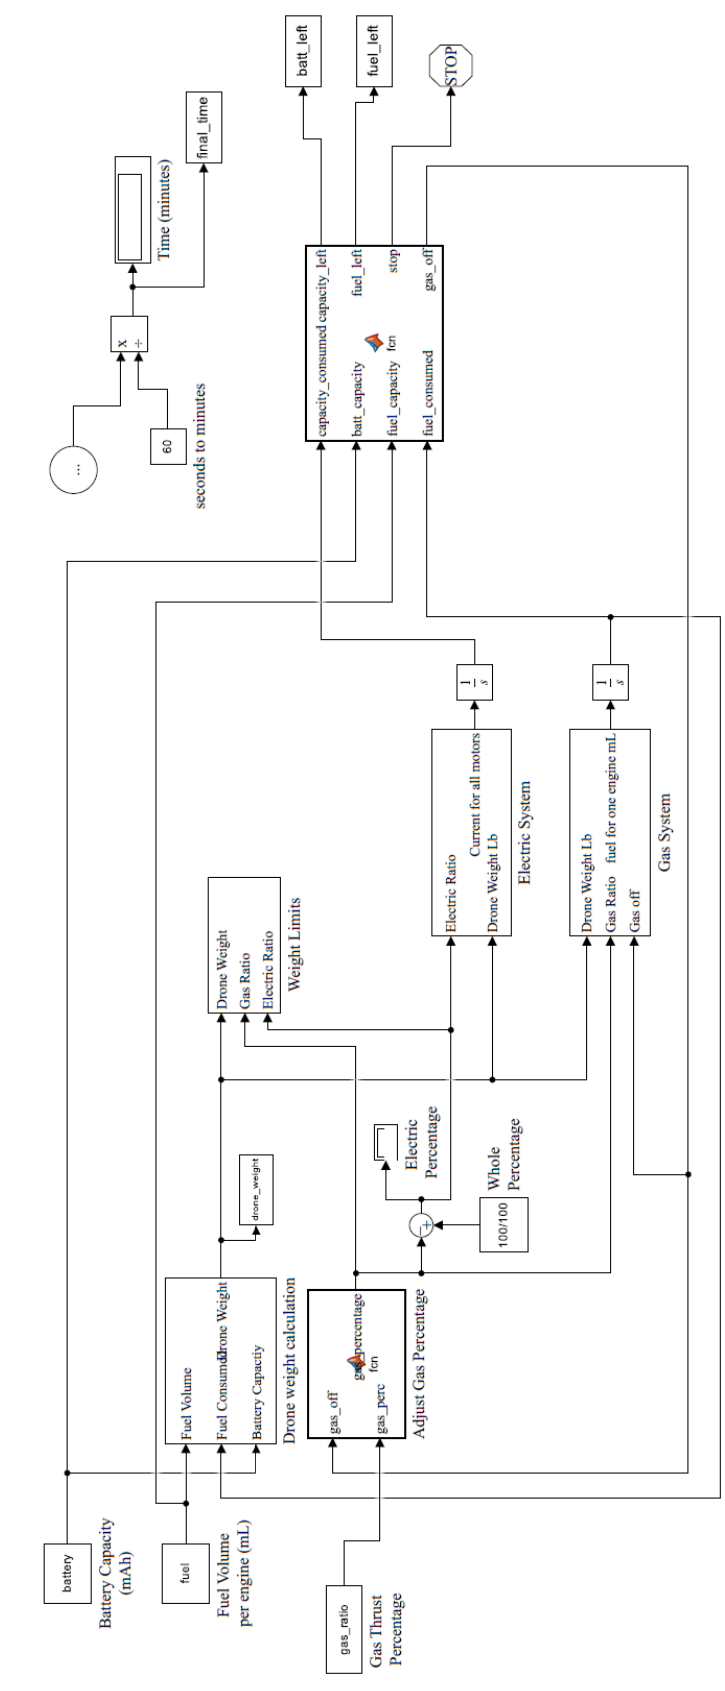
Figure 14. Hybrid gasoline–electric system